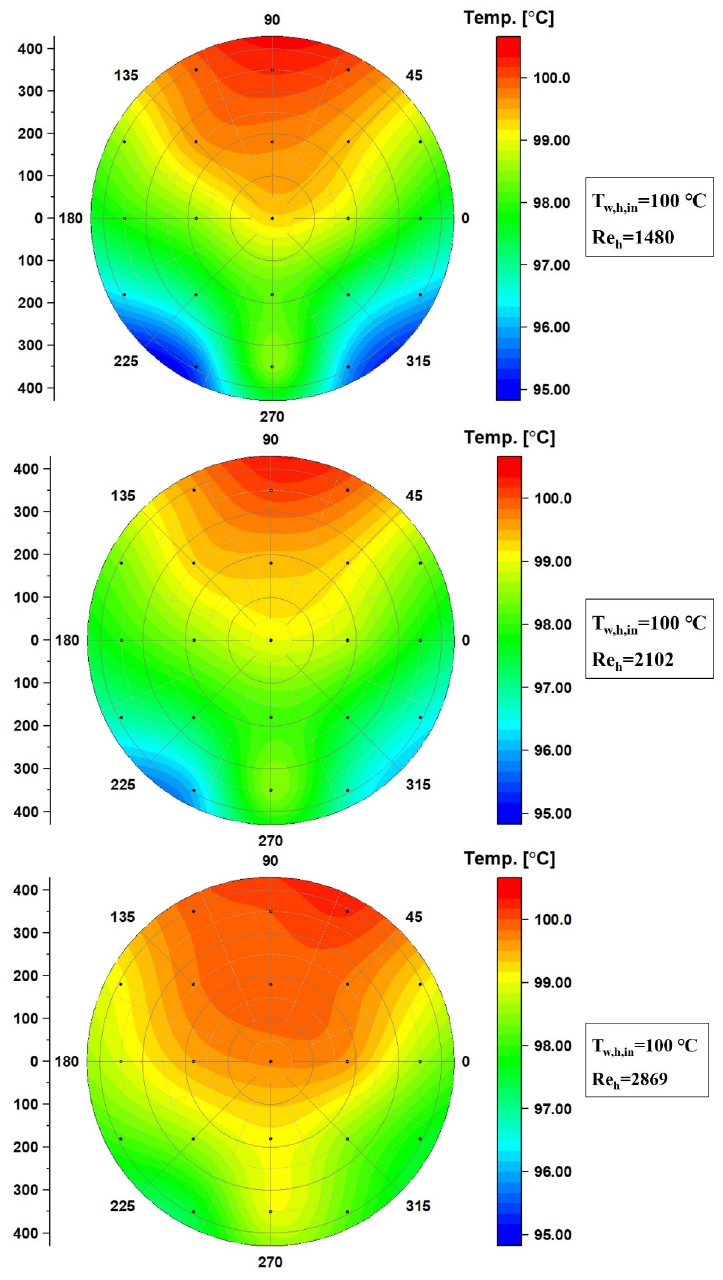
Figure 13. The temperature profile on the circular plate with respect to the Re at 100 °C.